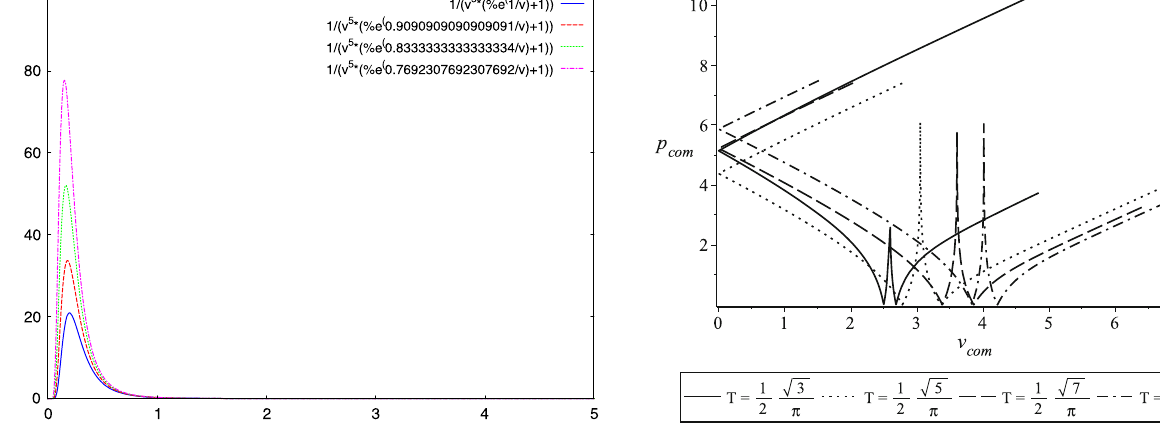
Fig. 4 P – V diagram for the thermodynamic volume given by V = π r 3 = 3 4 for SAdS black holes. Here from bottom + and pressure P 3 8 π l 2